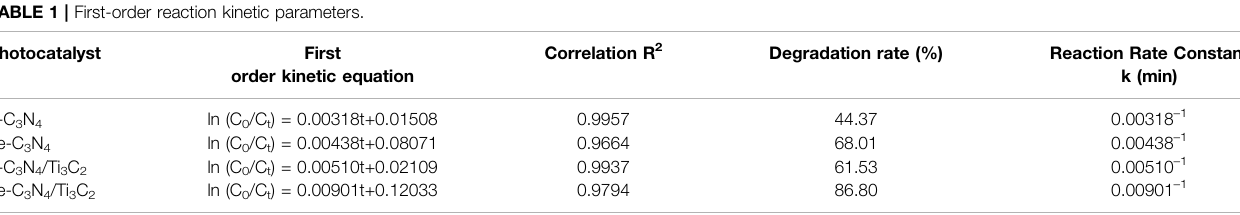
TABLE 1 | First-order reaction kinetic